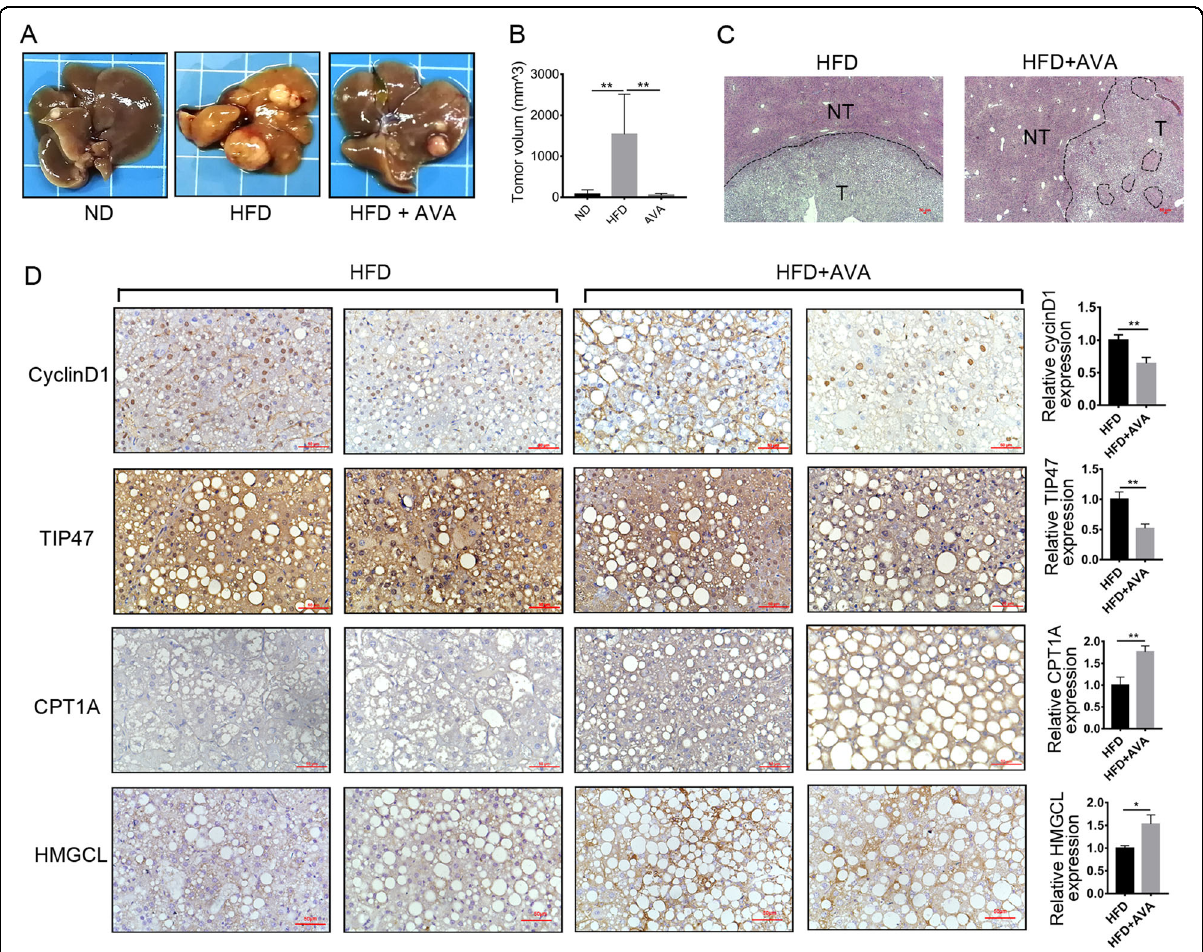
Fig. 5 Avasimibe suppressed tumor growth but enhances CPT1A expression in DEN-injected mice on HFD. A Protocol for AVA in DEN- injected mice fed a high-fat diet. The mice were randomly assigned to NT, NT + HFD, HFD, and HFD + AVA group, and each group had 12 mice. B – C Avasimibe dramatically suppressed HFD-promoted HCC tumor growth. Representative images of the livers ( B ) and tumor volumes ( C ) from each group of mice were shown; ** p < 0.01. D Representative H&E-stained images of HCC and adjacent non-tumor tissues from HFD or HFD + AVA group ( n = 5, scale bar: 50 μ m). T: tumor; NT: adjacent non-tumor. The circled position indicated no steatohepatitis area. E Representative IHC images of CyclinD1, TIP47, CPT1A, and HMGCL in tumor tissues from HFD-fed mice treated with or without AVA. Data were quanti fi ed using ImageJ software (means± SEM, n = 5); * p < 0.05, ** p <